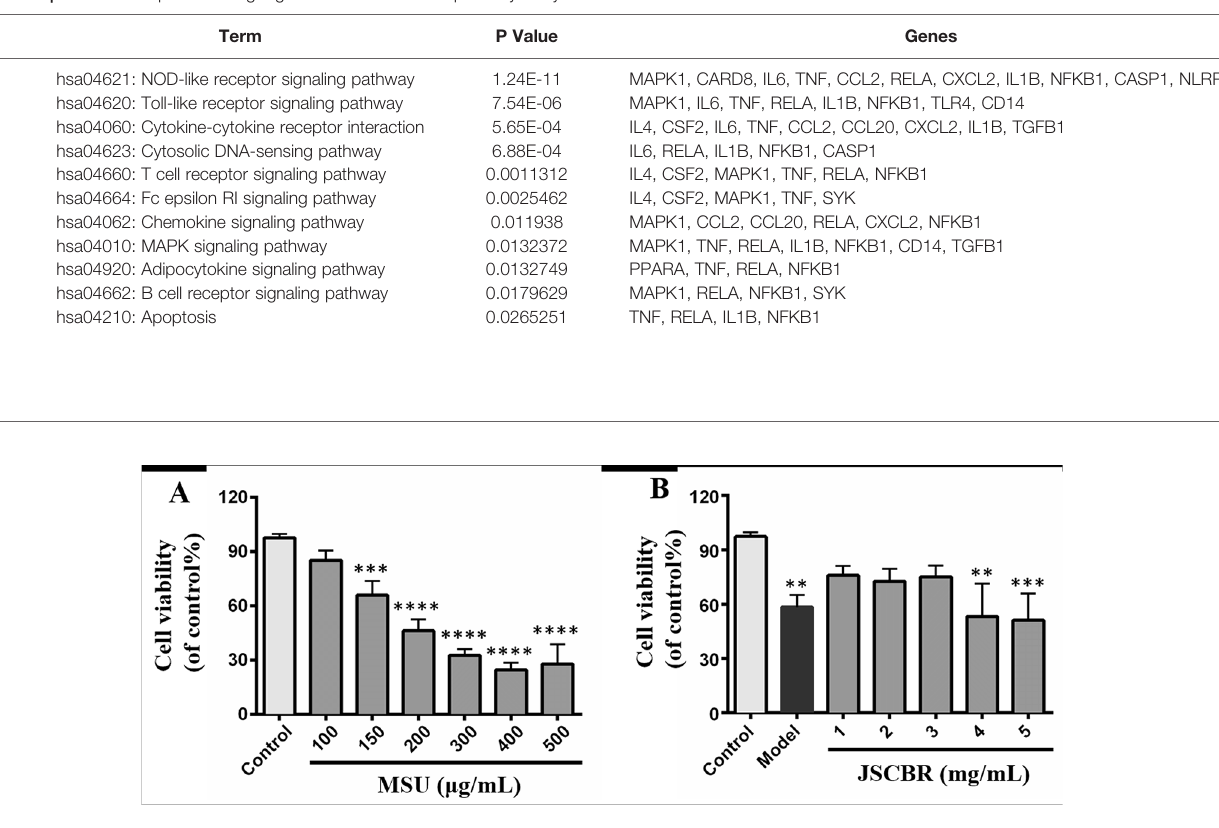
FIGURE 6 | Effects of Jiang-Suan-Chu-Bi recipe (JSCBR) extracts on monosodium urate (MSU)-induced THP-1 cell viability. (A) THP-1 cells were exposed to MSU at various concentrations for 24 h. (B) Protective effects of JSCBR extracts on the viabilities of MSU-induced THP-1 cells. Cell viability was assessed by CCK-8 assay and expressed relative to untreated control cells. ** p < 0.01, *** p < 0.001, **** p < 0.0001 versus control